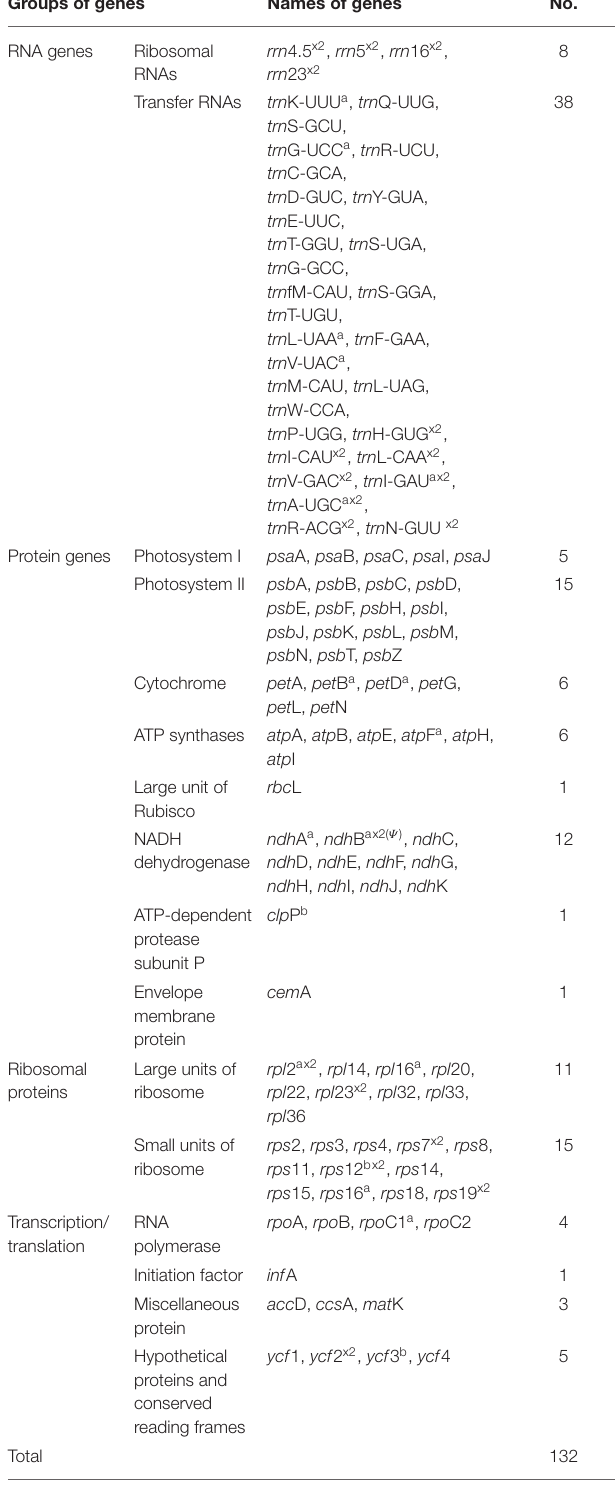
TABLE 2 | Gene composition within plastid genomes of Goodyera species. Groups of genes Names of